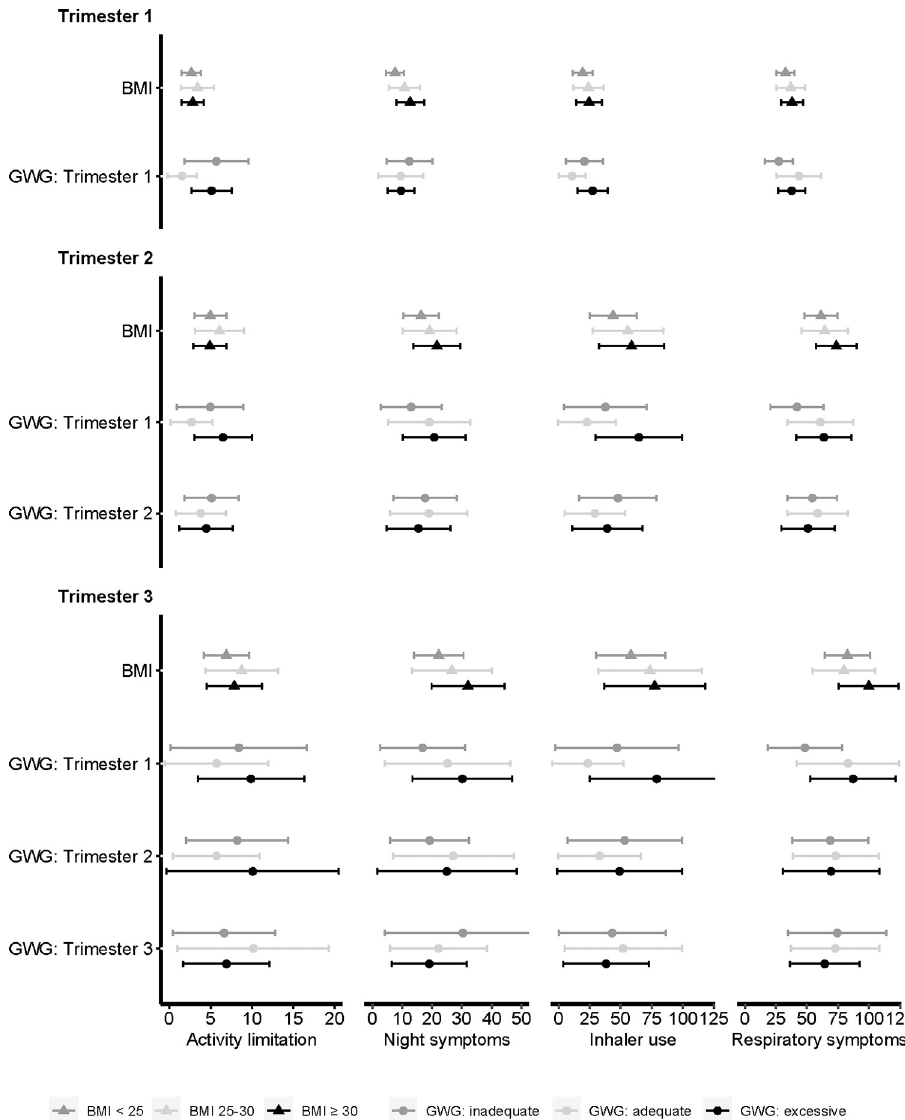
Fig 3. Estimated mean days and 95% confidence intervals of asthma symptom burden per trimester by pre- pregnancy BMI and GWG in the Breathe-Wellbeing, Environment, Lifestyle, and Lung Function Study, 2015– 2019, USA. Abbreviations: BMI, body mass index; GWG, gestational weight